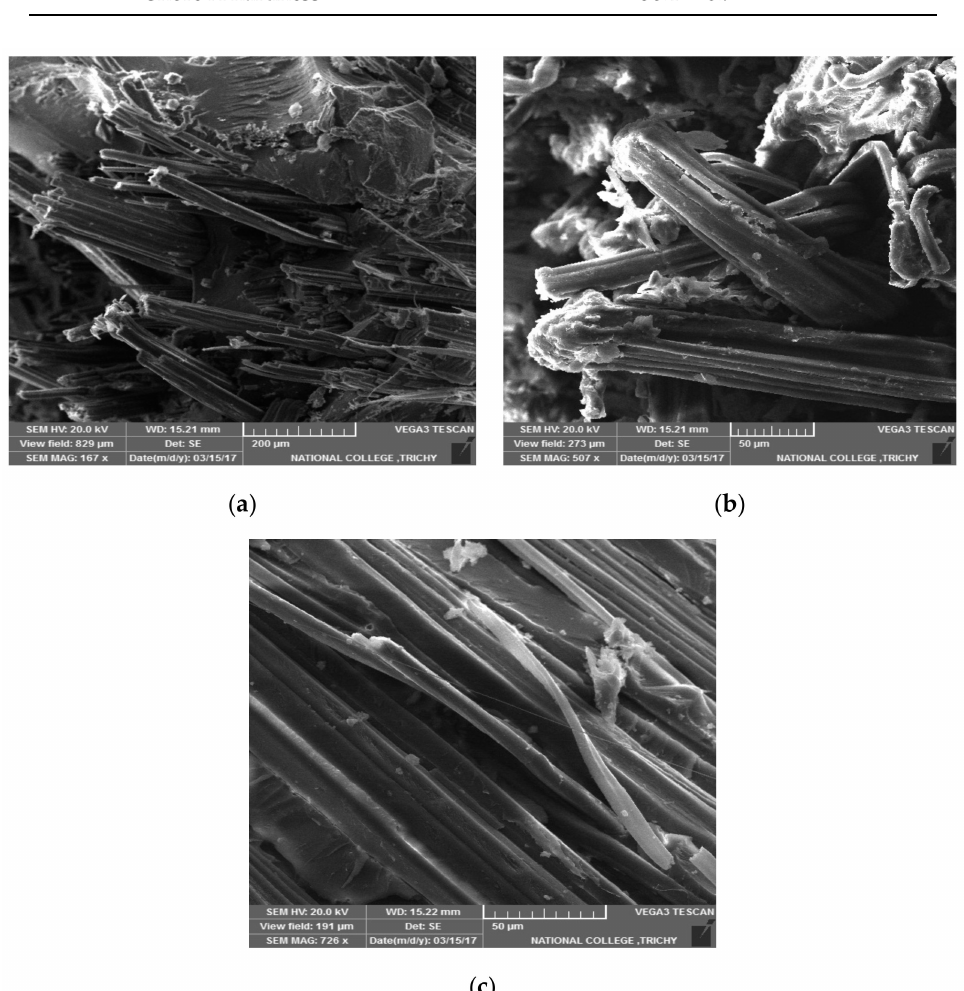
Figure 1. Morphological observations of the fractures by scanning electron microscopy (SEM). ( a ) Tensile fracture; ( b ) Flexural fracture; ( c ) Impact